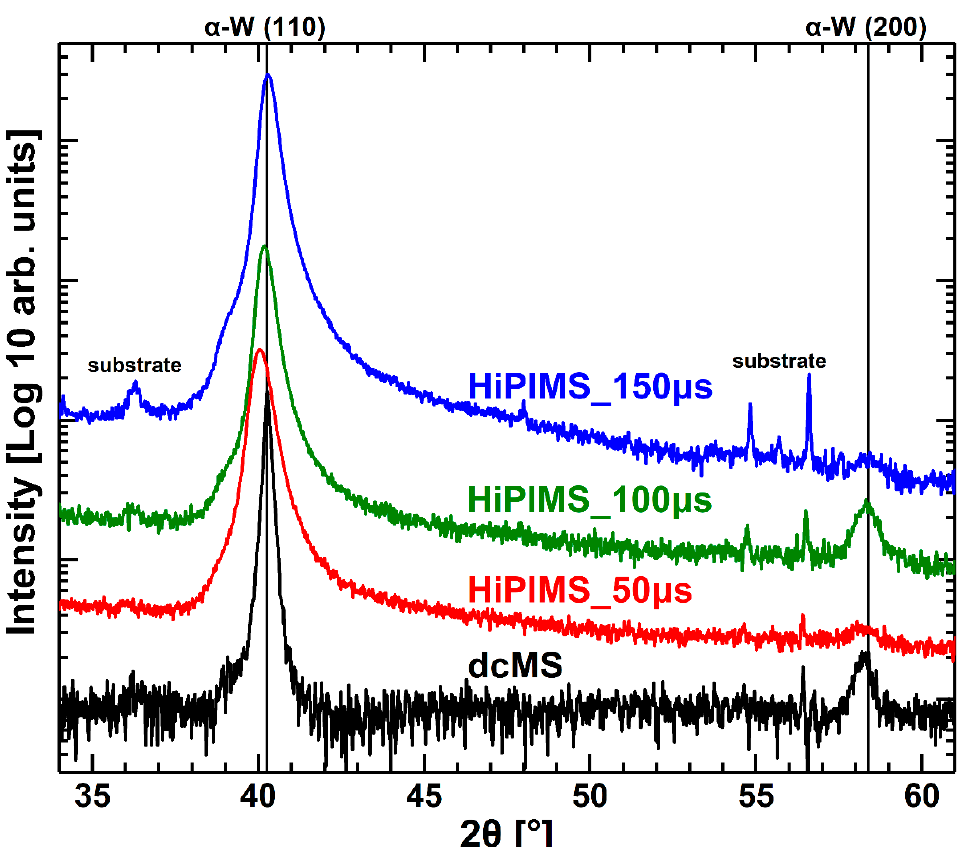
Figure 4. XRD spectra of W thin films prepared by dcMS and HiPIMS with varying pulse widths.